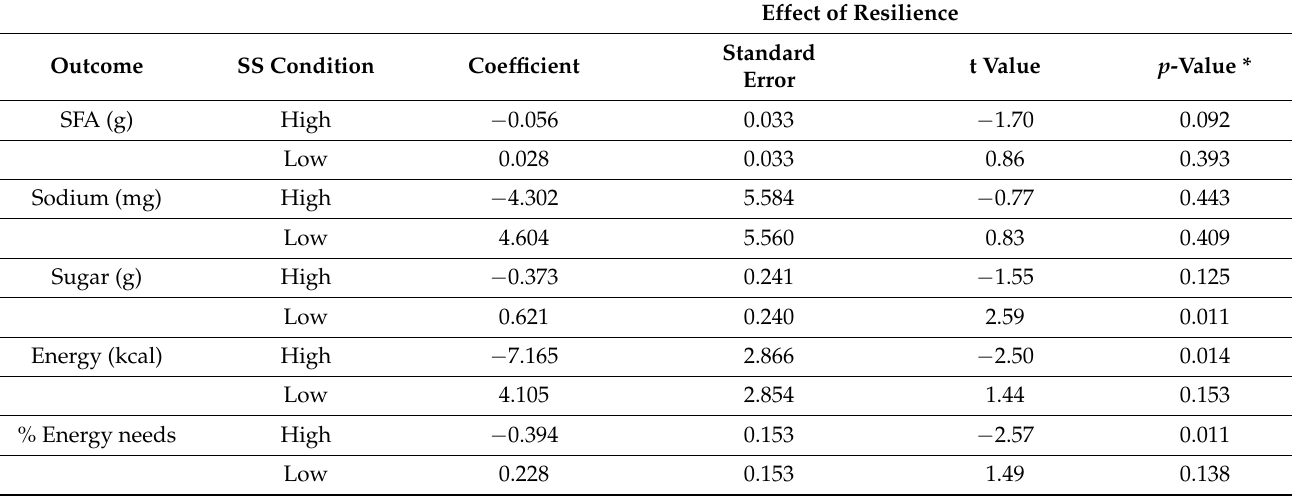
Table A3. The effect of resilience on dietary outcome variables within high or low experimentally manipulated SS